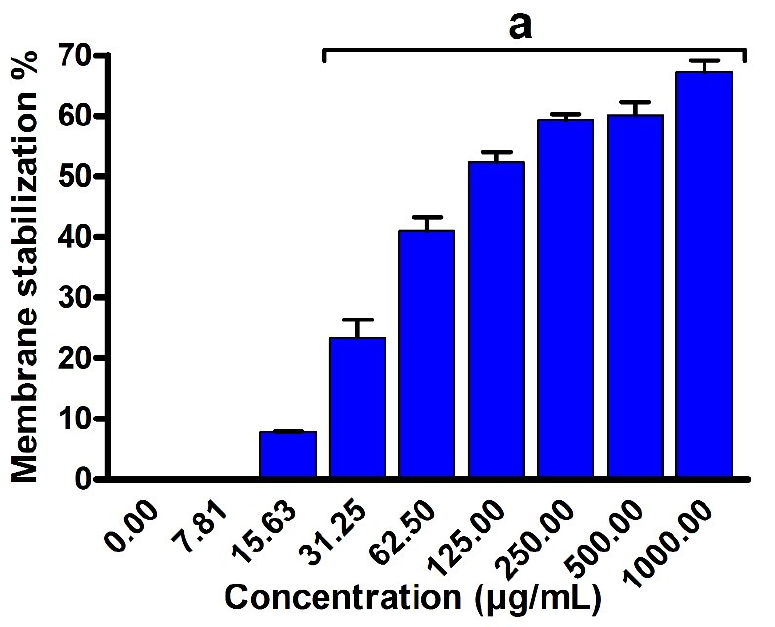
Figure 13. Assessment of the inhibitory activity of EPSR4 against hemolysis activity (membrane stability). Data are presented as mean ± SD. a p < 0.05 versus concentration of 0 µ g/mL.